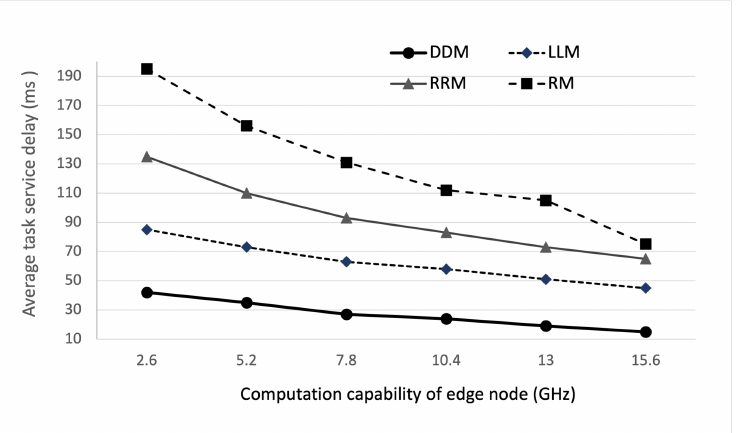
Figure 6. Average task service delay according to the computation capacity of edge